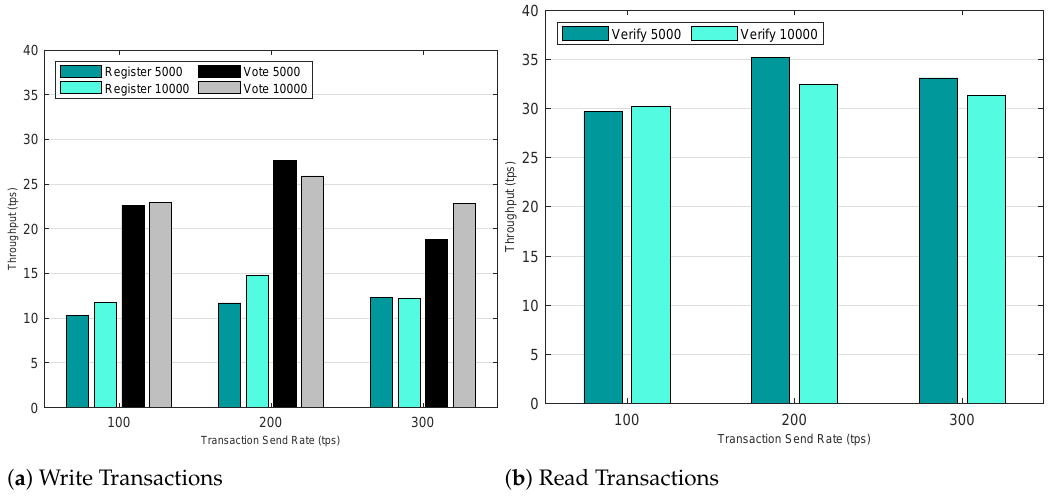
Figure 6. The impact of increasing the number of transactions on latency and